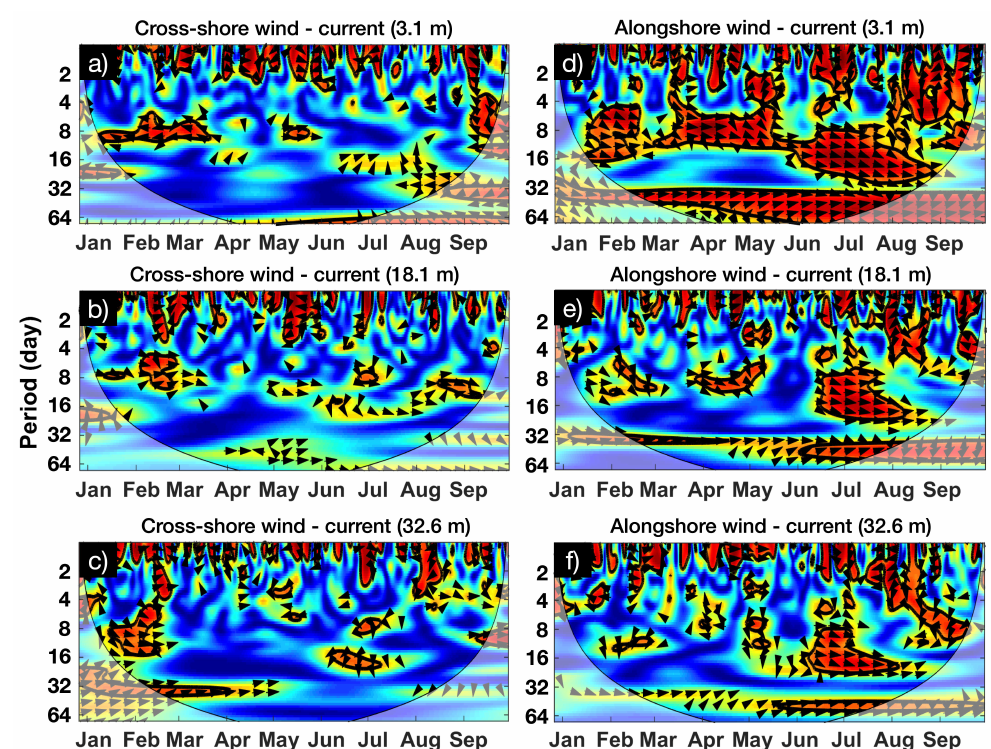
Figure 4. Coherence between time series of alongshore and cross-shore winds at Hualpen Point and currents (January–September 2009) at three depth levels (3.1 m, 18.1 m and 32.6 m). ( a – c ) Cross- shore and ( d – f ) alongshore wind and current components, respectively. Statistically significant (95% confidence level) values are shown in red and are highlighted with black lines. Blue colors indicate areas of low spectral coherence. Shaded areas denote the cone of influence of the wavelet computations. In all panels, black arrows indicate the phase between the wind and current time series. The time series are in phase when the arrows point to the right (90°), and out phase when pointing to the left